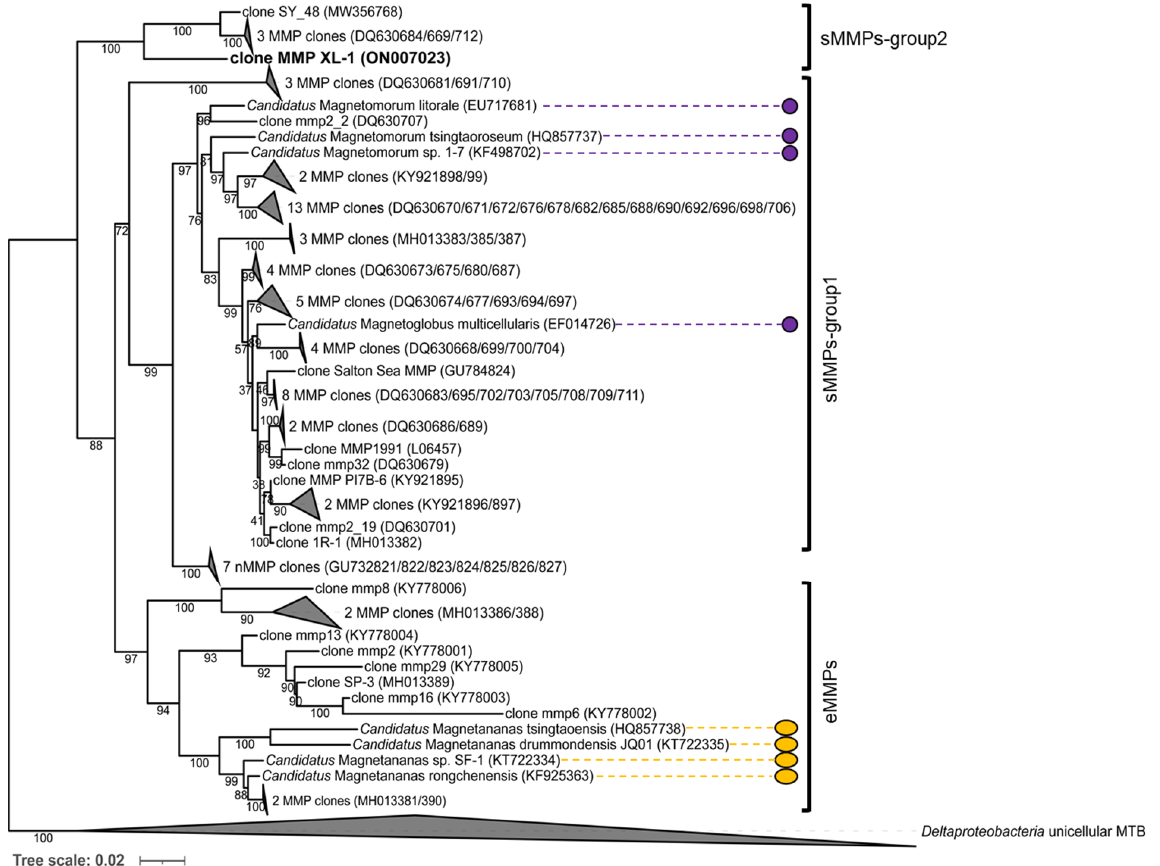
Figure 4. Phylogenetic tree based on 16S rRNA gene sequence analysis. The phylogenetic tree was constructed using the maximum likelihood method using IQ-TREE software. Bootstrap values were calculated using 1000 replicates. The acquired sMMP sequence is indicated in bold. GenBank accession numbers are shown in parentheses. The scale bar represents 2% sequence divergence. The morphologies and characteristics of the sMMPs (labeled by the purple circles) and the eMMPs (labeled by the orange ellipses) have been